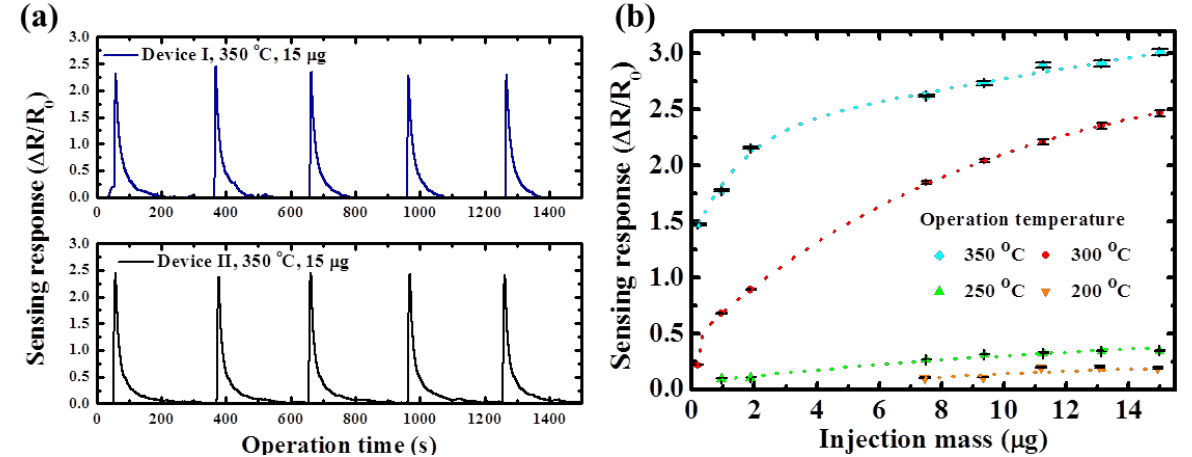
Figure 7. ( a ) Reliability test for devices ( b ) Effect of ethanol concentrations on the sensing response and corresponding standard deviations of TiO operating